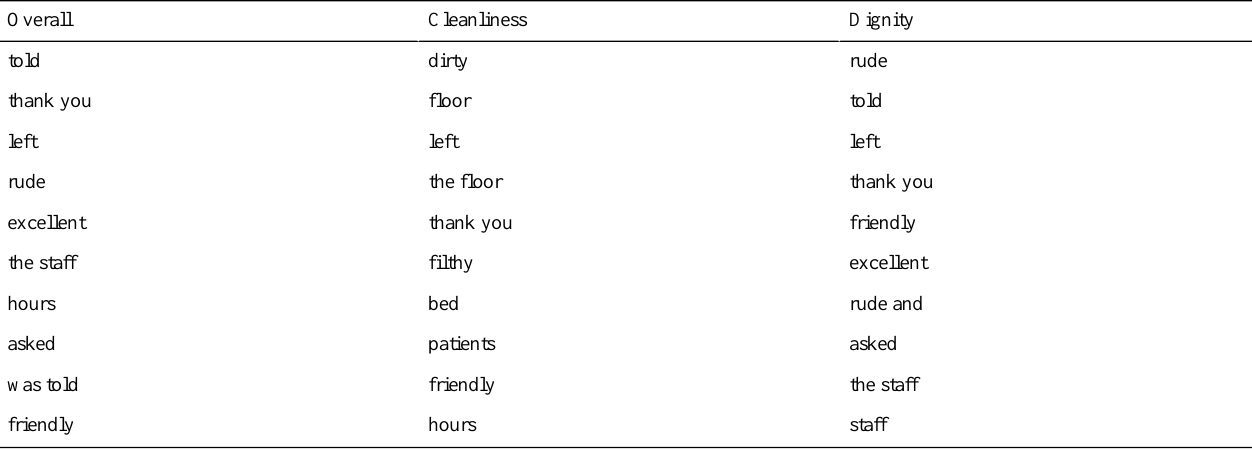
Table 2. The 10 one or two word phrases with the highest predictive accuracy for each topic.